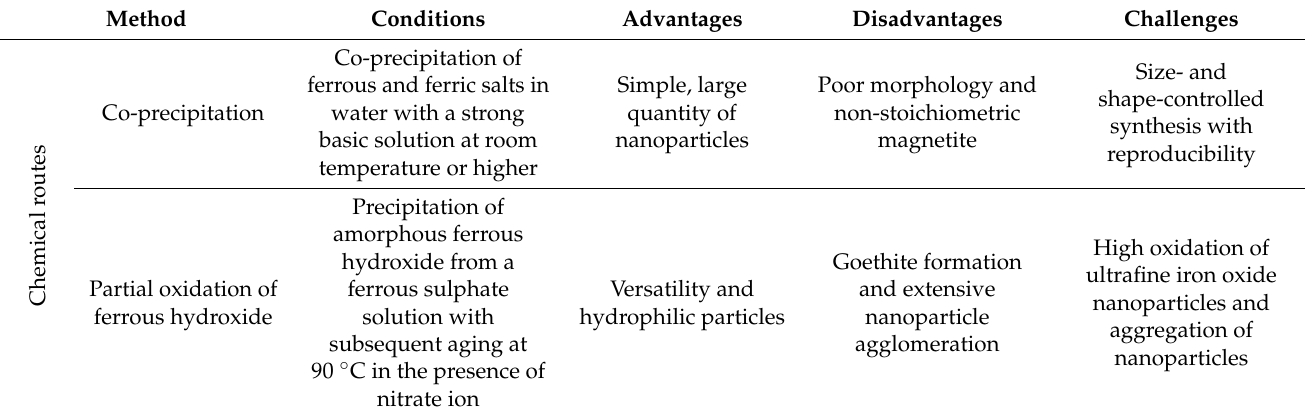
Table 2. Magnetic nanoparticles (MNP) synthesis and their comparison in terms of synthetic routes, advantages, disadvantages, and